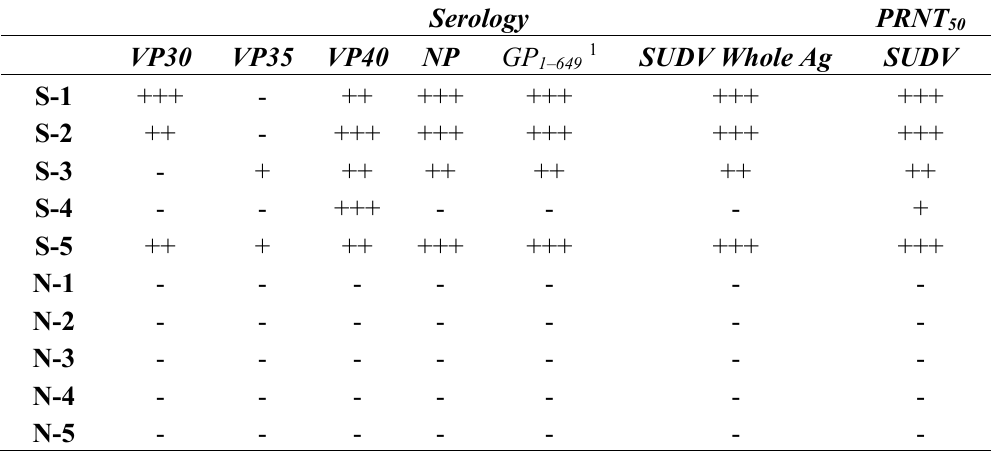
Table 1. Serology and neutralization of Kibaale survivors. Summary of ELISA immunoreactivity, and PRNT 50 , in human survivor sera from Kibaale (S1–S5) and non-infected controls (N1–N5), against the different viral recombinant proteins of SUDV and the whole viral antigen.